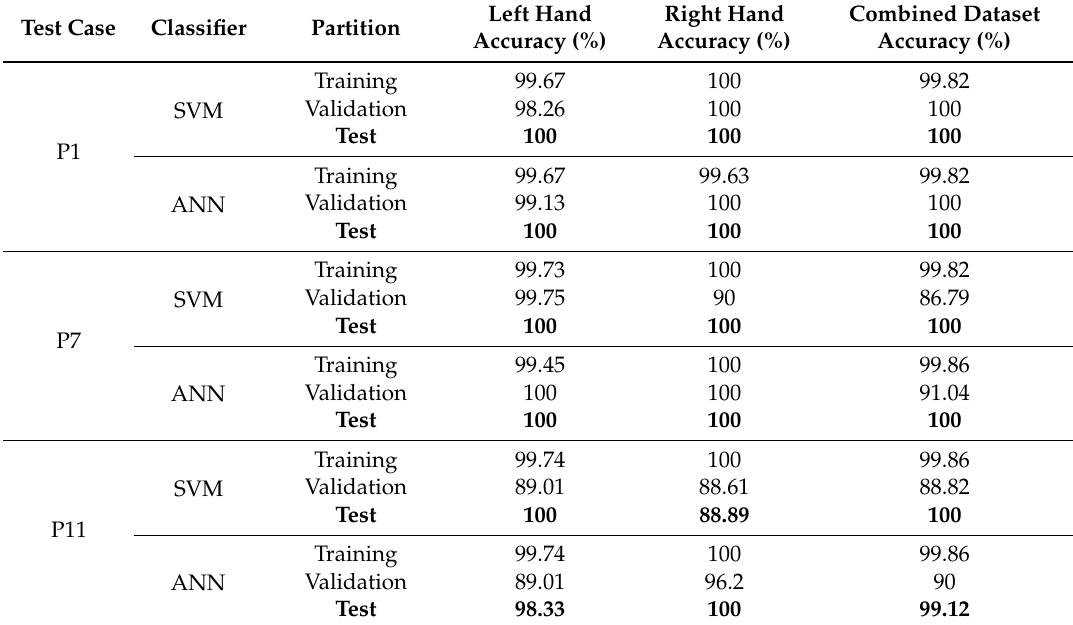
Table 8. Training, validation and test set accuracies (User Specific, PCA and velocity